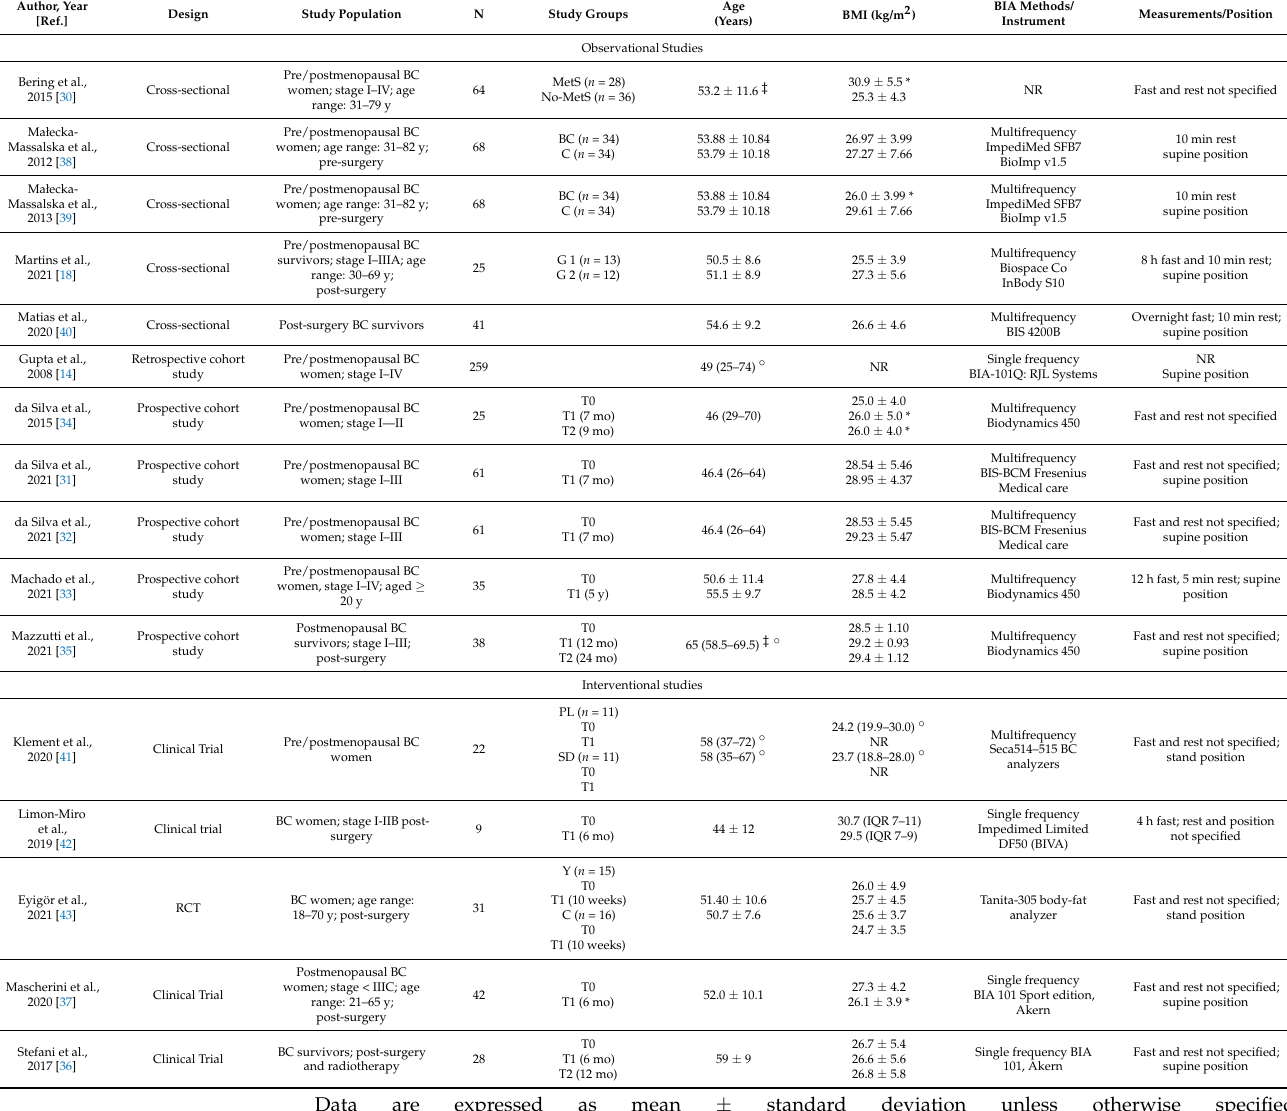
Table 1. Characteristics of the included